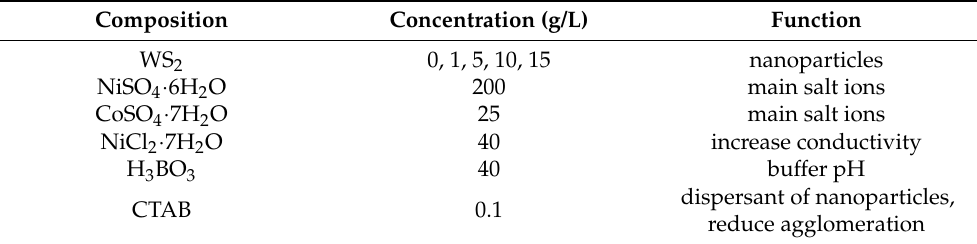
Table 1. The composition of the electroless plating solution. Composition Concentration (g/L)